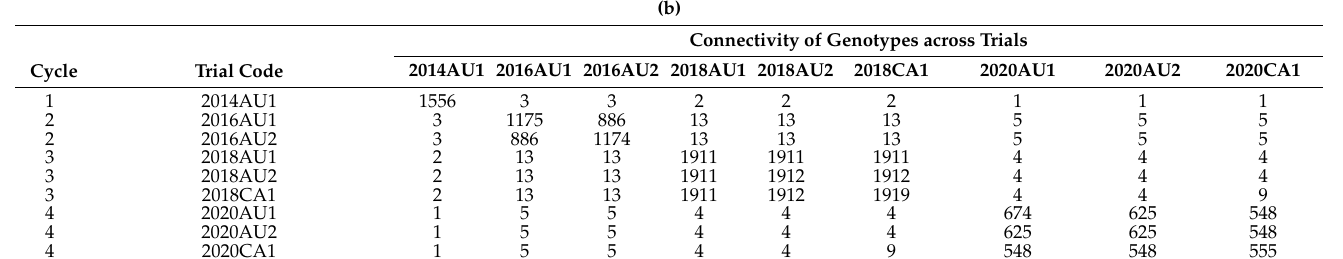
(b) Connectivity of Genotypes across